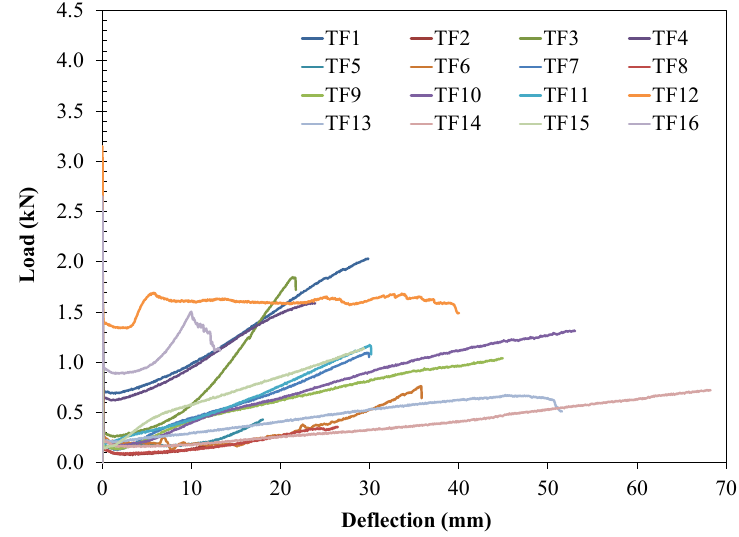
Figure 13. Load ‐ deflection behavior of textile fabrics in weft direction.